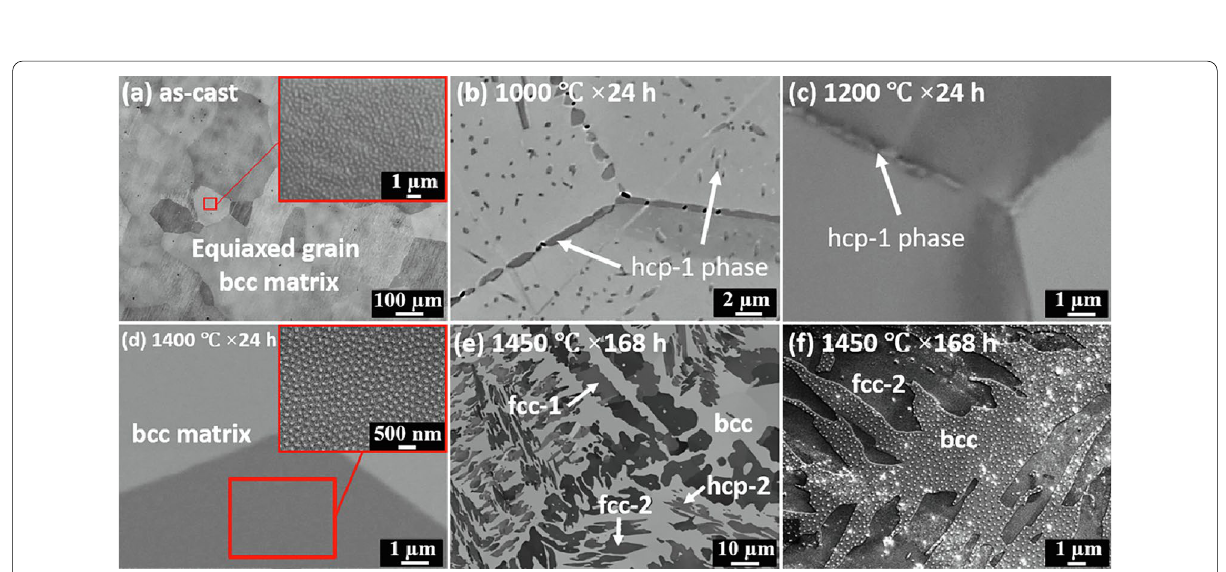
Figure 22 Microstructure evolution of HfNbTaTiZr RHEA at various conditions [45] ( a ) as-cast, ( b ) 1000 °C, 24 h, ( c ) 1200 °C, 24 h, ( d ) 1400 °C, 24 h, ( e ) 1450 °C, 168 h, ( f ) magnification of ( e